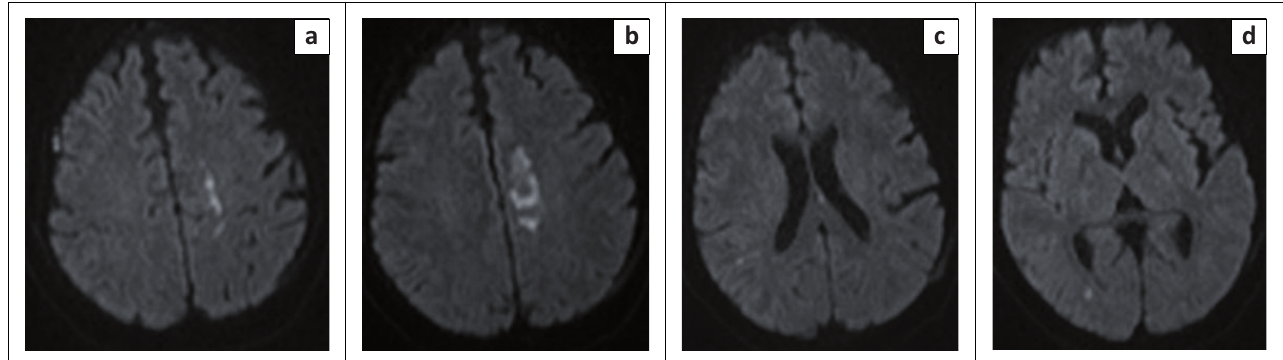
FIGURE 5: Axial diffusion-weighted b1000 MR images (a, b, c and